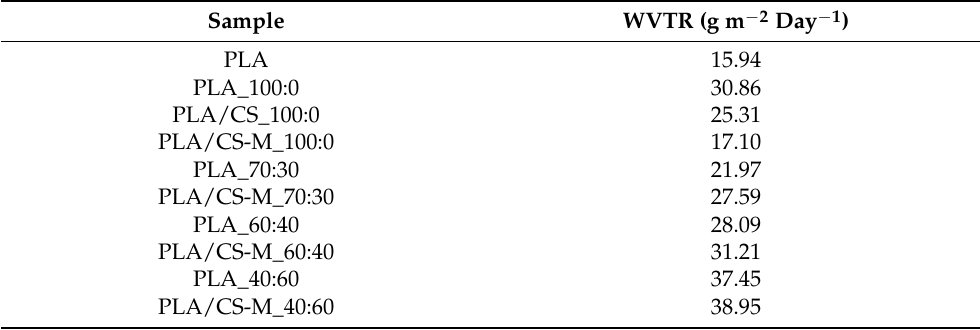
Table 4. Water vapor permeability of PLA-based biocomposites, plasticized PLA and neat PLA.